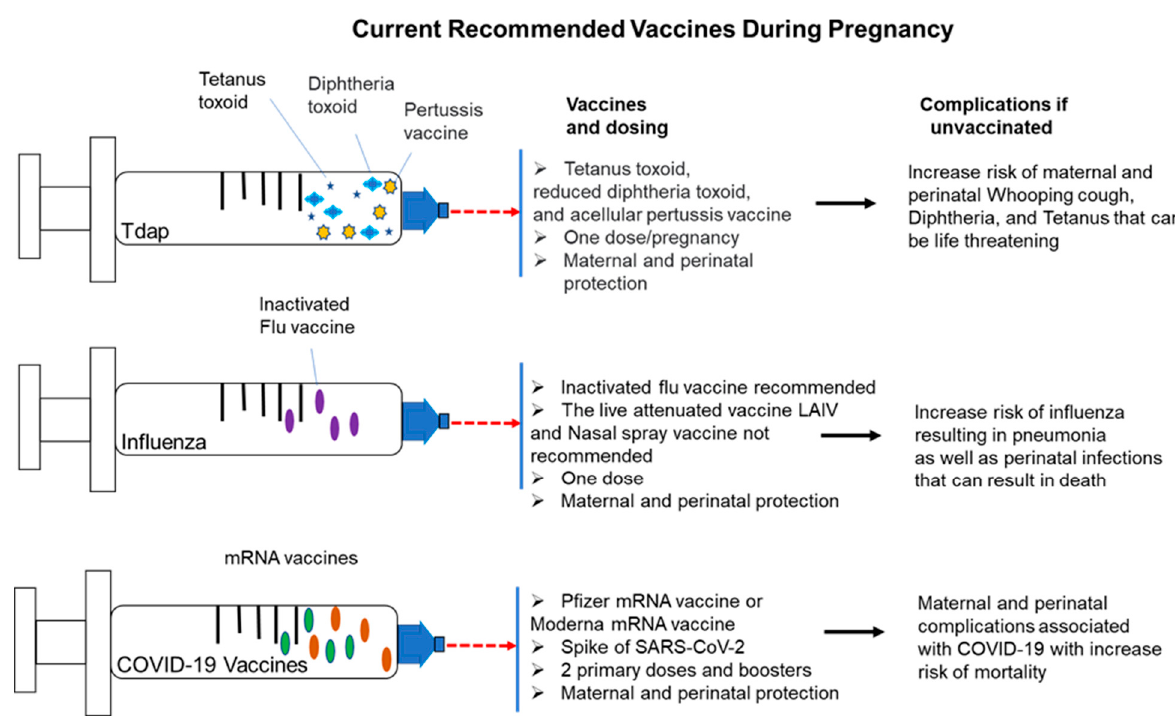
Figure 1. Currently recommended vaccines for pregnant women in the US.